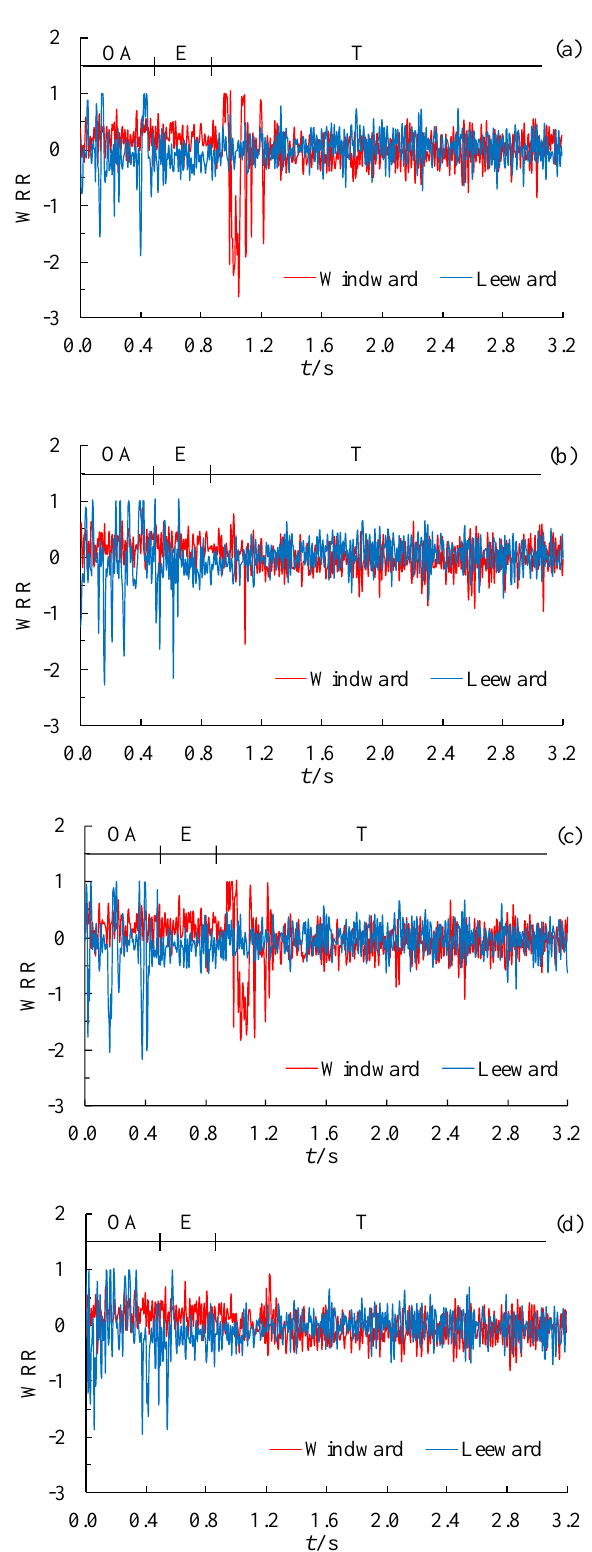
Figure 20. Time-history of head carriage WRR conditioned train speed 250 km/h, crosswind velocity 15 m/s, ( a ) 1st wheelset, ( b ) 2nd wheelset, ( c ) 3rd wheelset, ( d ) 4th wheelset (open air (OA); entering entrance (E); tunnel (T)).